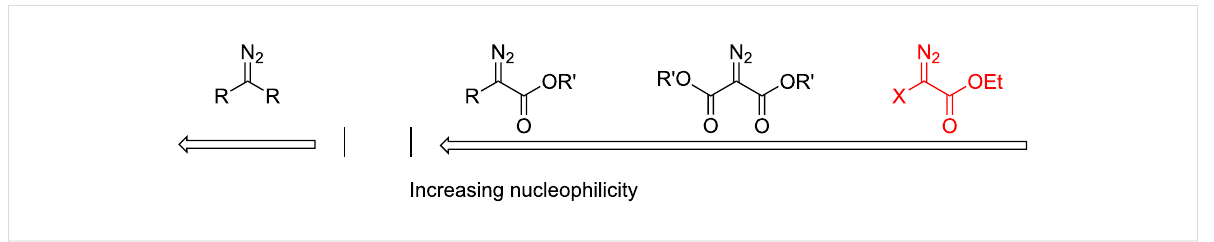
Figure 8: Relative nucleophilicity of halodiazoacetates (red